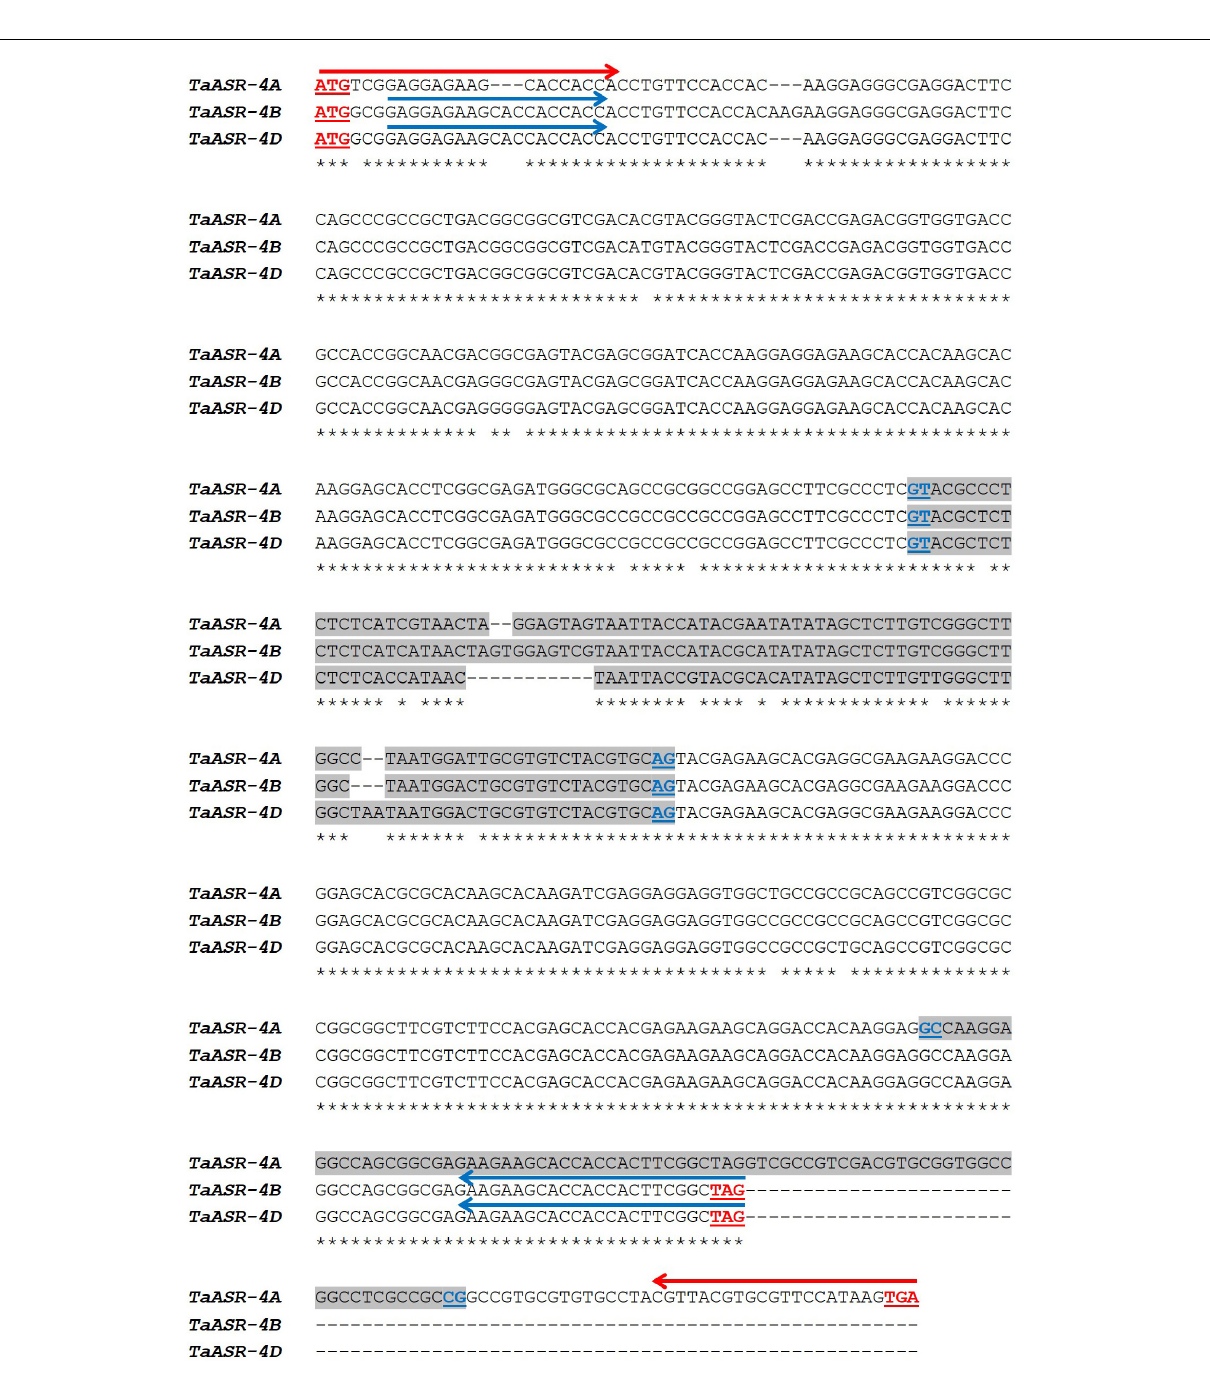
TtASR-4B genes. Oligo sequences were checked for nucleotide composition to avoid the formation of primer-dimers or hairpin loops. Primer sequences and position are reported respectively